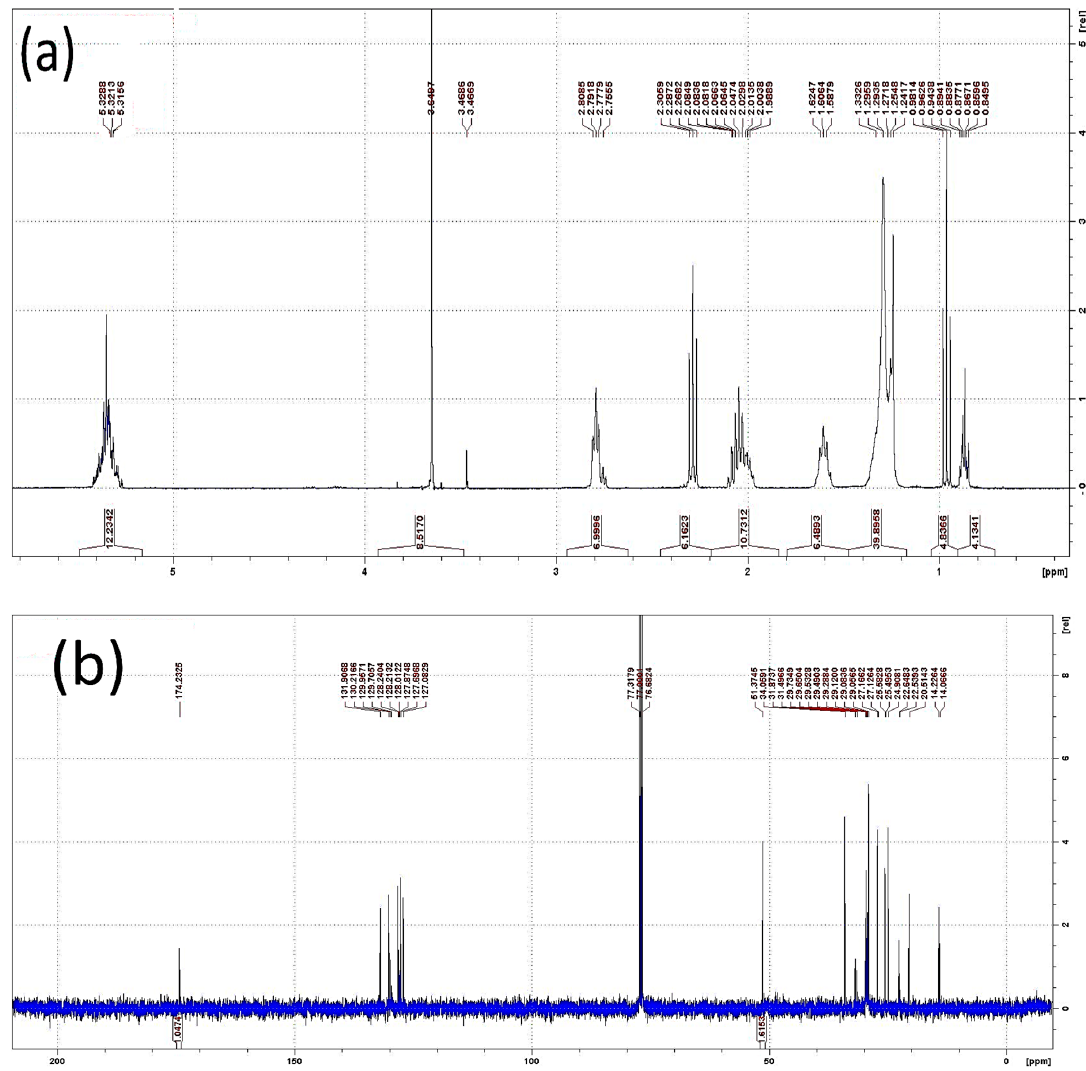
Figure 6. ( a ) . The 1 H NMR for the biodiesel sample obtained with TiO 2 -0.5Li ( b ). The 13 C NMR for the biodiesel sample obtained with TiO 2